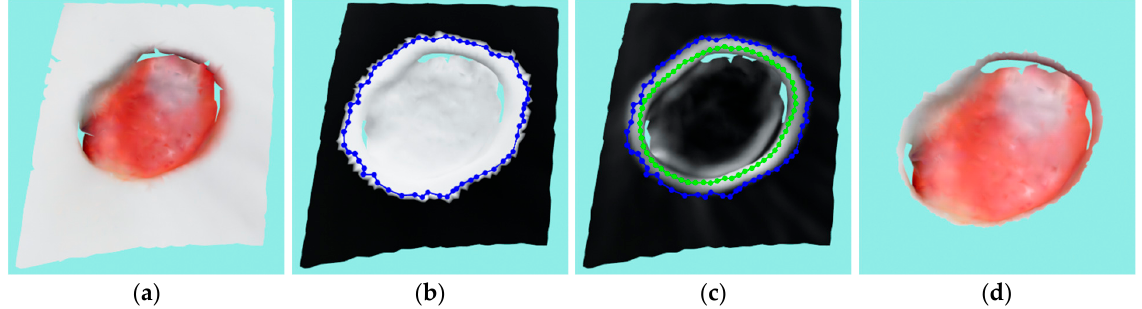
Figure 16. Case study for stage 3 pressure ulcer: ( a ) input wound mesh; ( b ) masked wound mesh with initial contour; ( c ) wound mesh with curvature texture and initial and final contours shown in blue and green colors, respectively; ( d ) final cut wound mesh model.